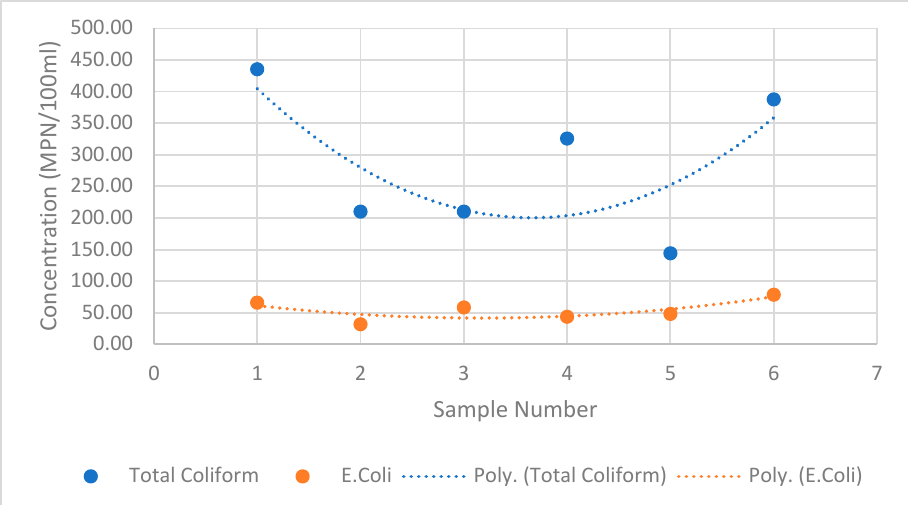
Figure 5. Variation of E. coli and Total Coliform counts with time with a different hybrid mixture.